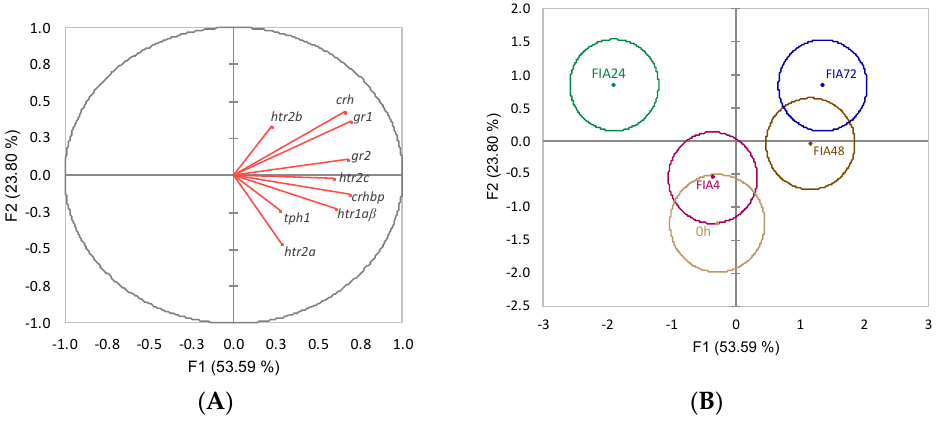
Figure 6. Canonical discriminant analysis of European seabass hypothalamic expression of HPI-axis-related genes. ( A ) Correlation variables/factors (factor loads) for two main discriminant functions (F1 and F2); gr1 , glucocorticoid receptor 1; gr2 , glucocorticoid 2; htr1a β , serotonin receptor 1A β ; htr2a , serotonin receptor 2A; htr2b , serotonin receptor 2B; htr2c , serotonin receptor 2C; tph1 , tryptophan hydroxylase 1; crh , corticotropin-releasing hormone; crhbp , crh-binding protein. ( B ) Canonical discriminant scores of each group. Groups centroids are marked by a small diamond, whereas circles indicate data distribution per group.